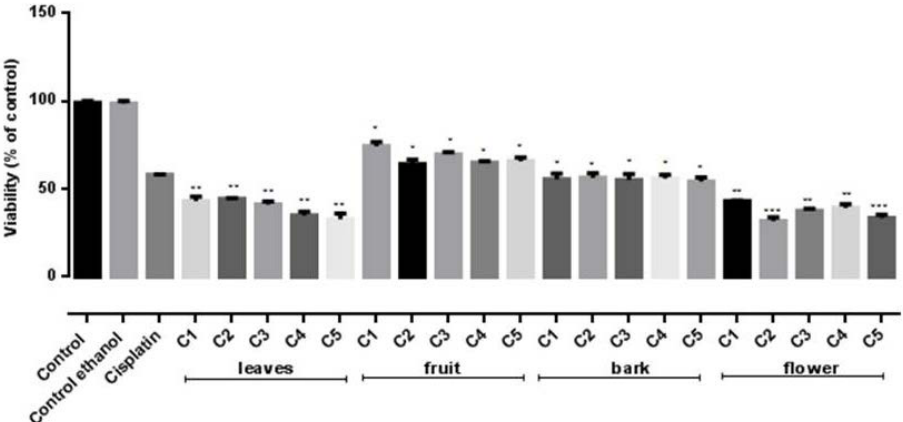
Figure 3. Inhibitory effects on Hela cell line of S. vulgaris leaves, fruit, bark and flowers extracts at five different concentrations C1–C5 calculated according to the TPC ( µ mol GAE/mL) determined for each extracts: leaves (11.34–56.7 µ mol GAE/mL), fruit (6.66–33.2 µ mol GAE/mL), bark (9.875–49.37 µ mol GAE/mL) and flowers (11.69–58.475 µ mol GAE/mL); Negative control—untreated cells, Internal control—Ethanol, Positive control—Cisplatin. Values represent the mean ± SD of three determinations. * p < 0.05; ** p < 0.001; *** p < 0.0001 (Differences between extract—treated cells and the negative control).